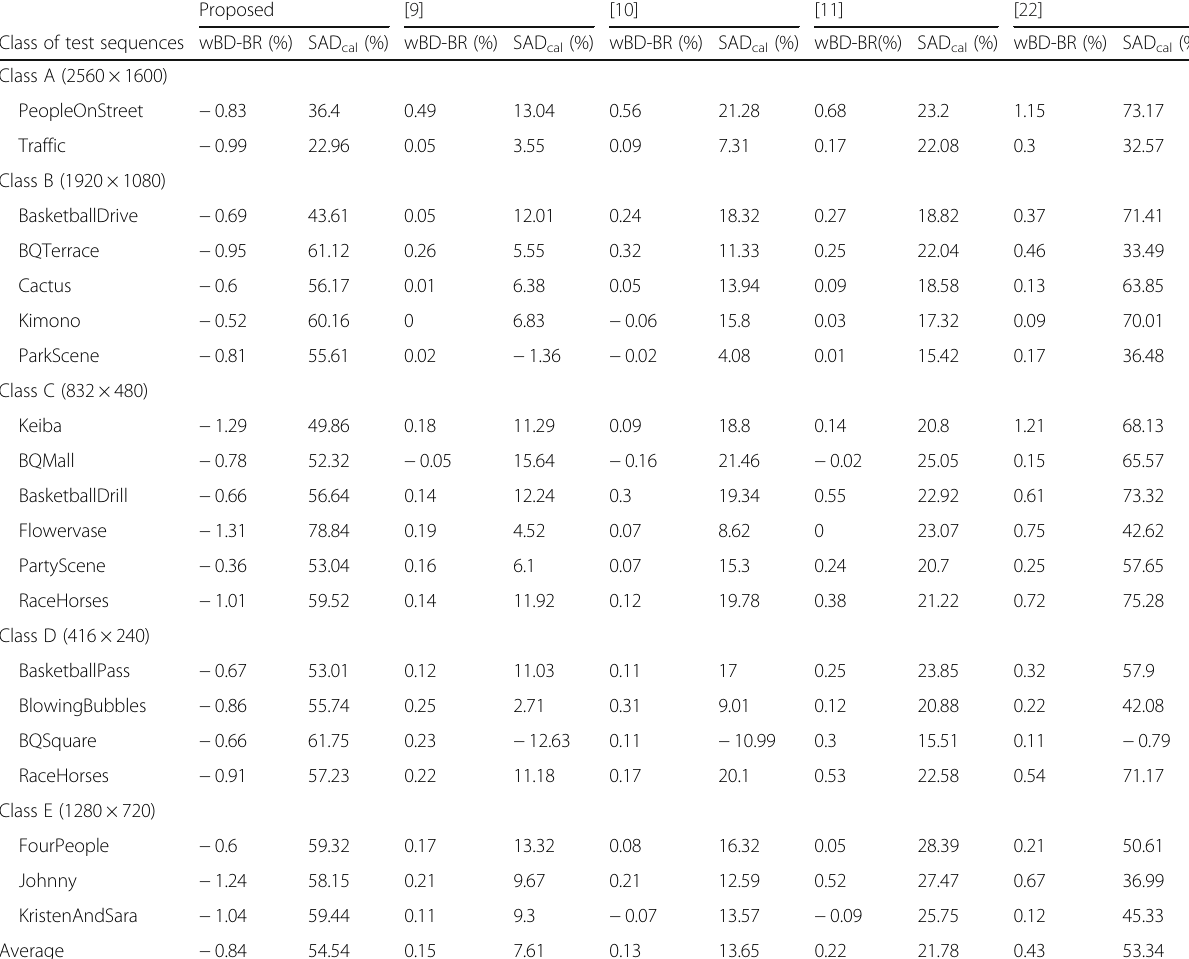
Table 3 Performance evaluation of the proposed algorithm and previous works Proposed